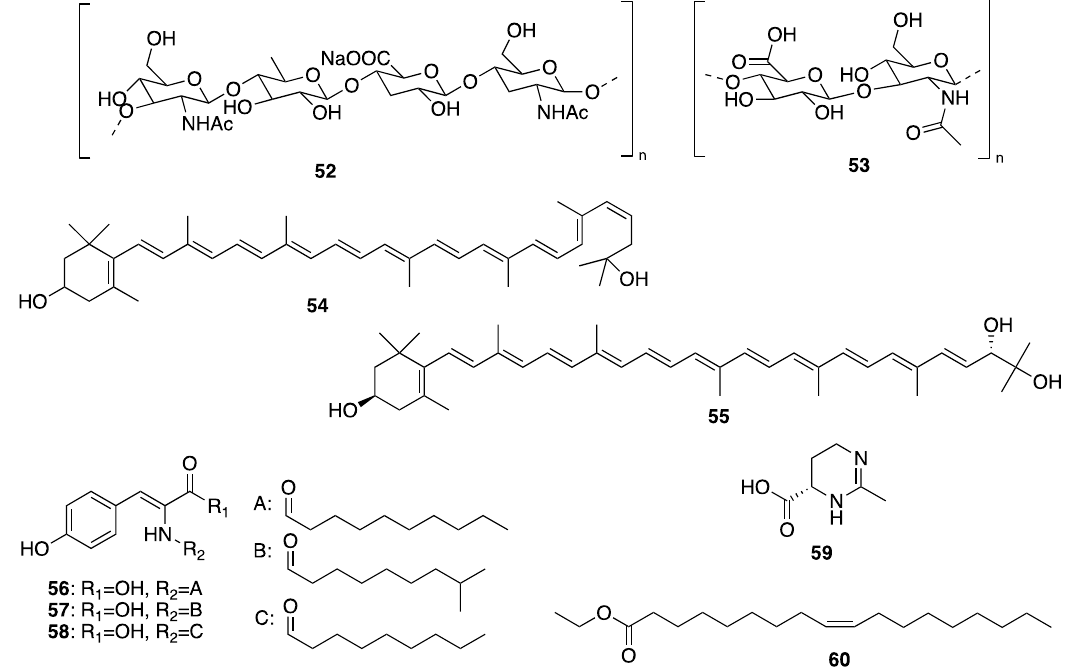
Figure 9. Structures of exopolysaccharide ( 52 ), hyaluronic acid ( 53 ), saproxanthin ( 54 ) , myxol ( 55 ), thalassotalic acids A ( 56 ), B ( 57 ), and C ( 58 ), ectoine ( 59 ), and ethyl oleate ( 60 ).